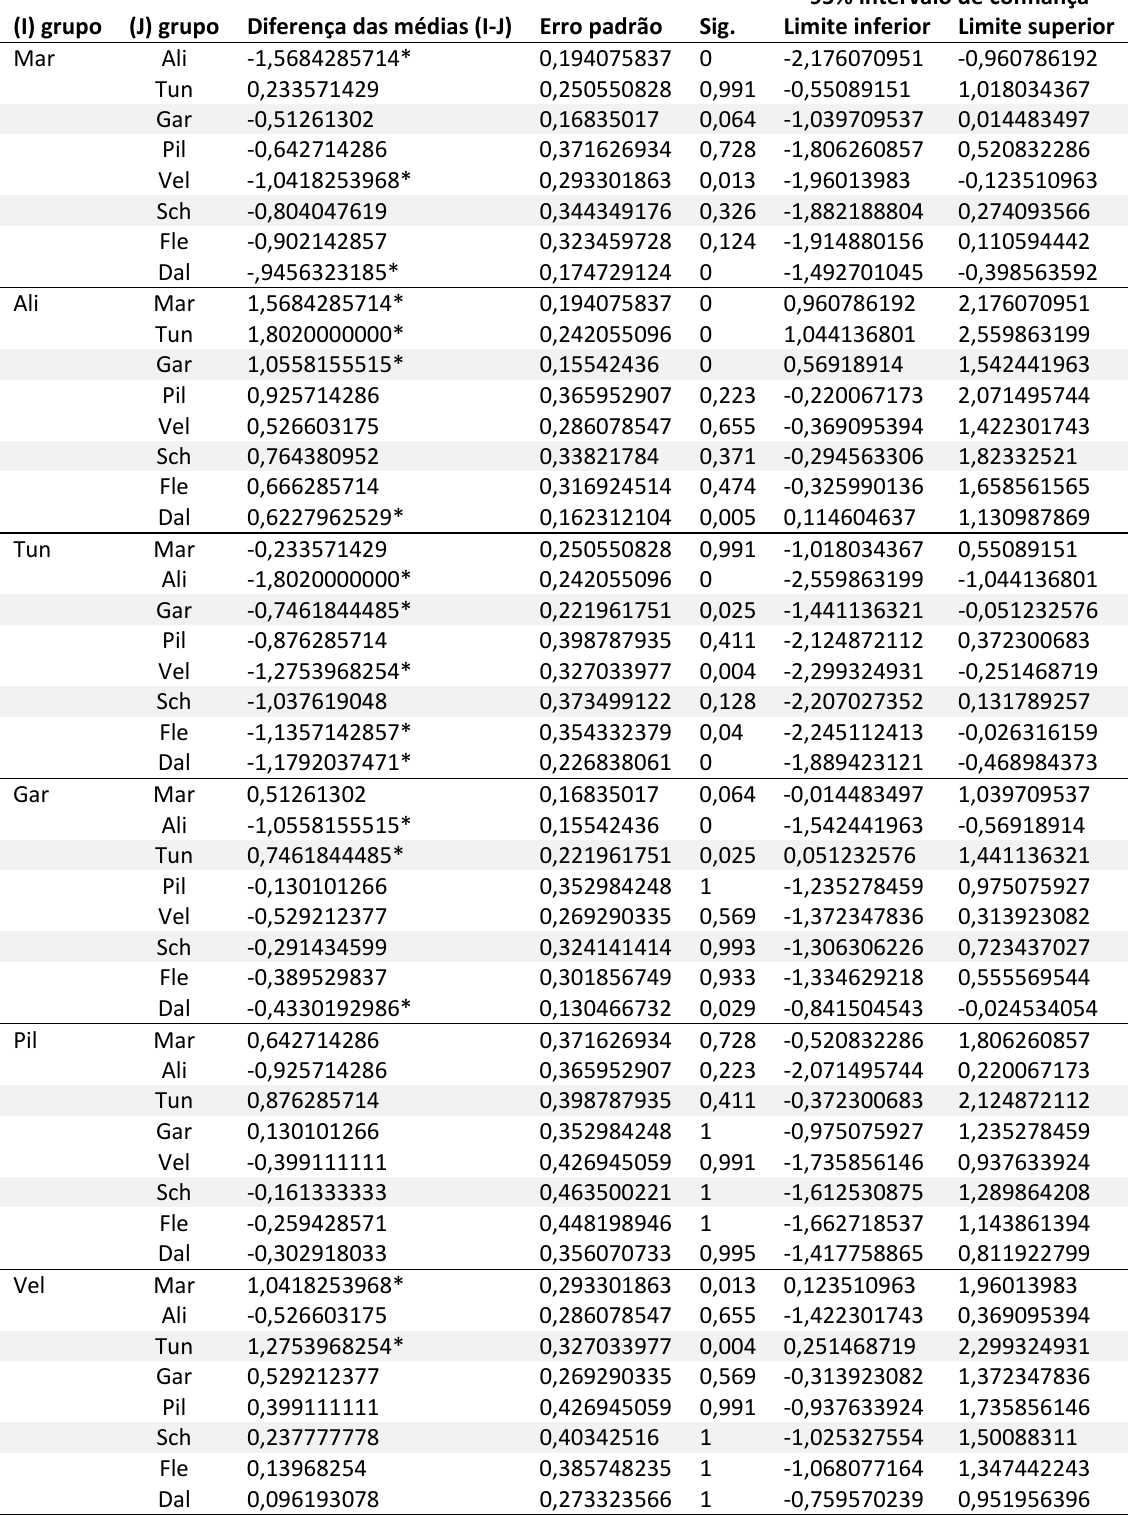
Table 5. Results of the application of the Tukey method. * pairs of means where significant differences at the level of 0.05 were